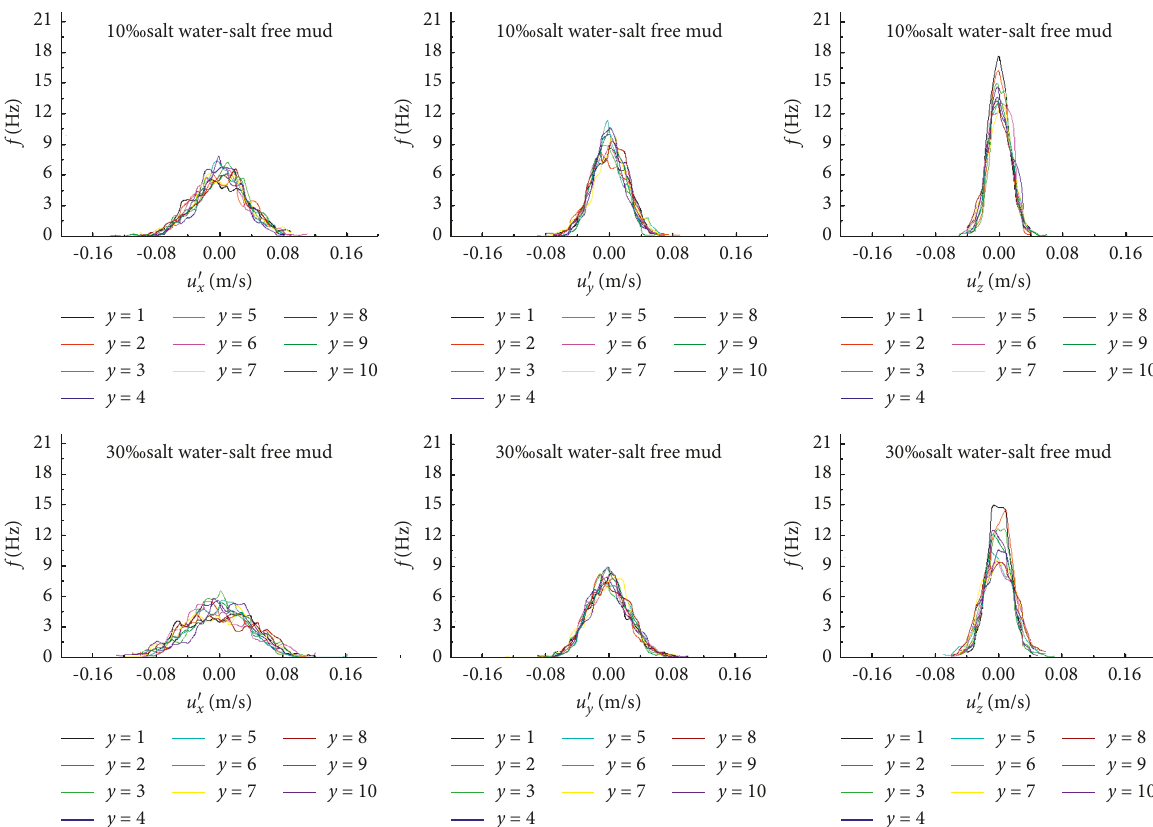
Figure 7: Probability distribution of turbulence velocity under critical condition of the muddy clay